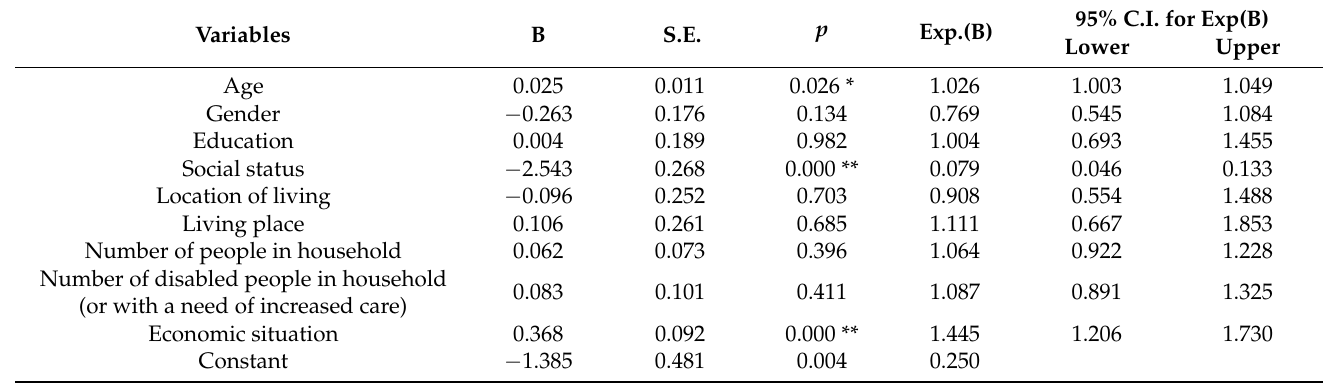
Table 5. Multiple logistic regression analysis investigating factors (basic attributes and characteristics of the respondents) relating to respondent’s preventive behaviour and disaster preparedness.